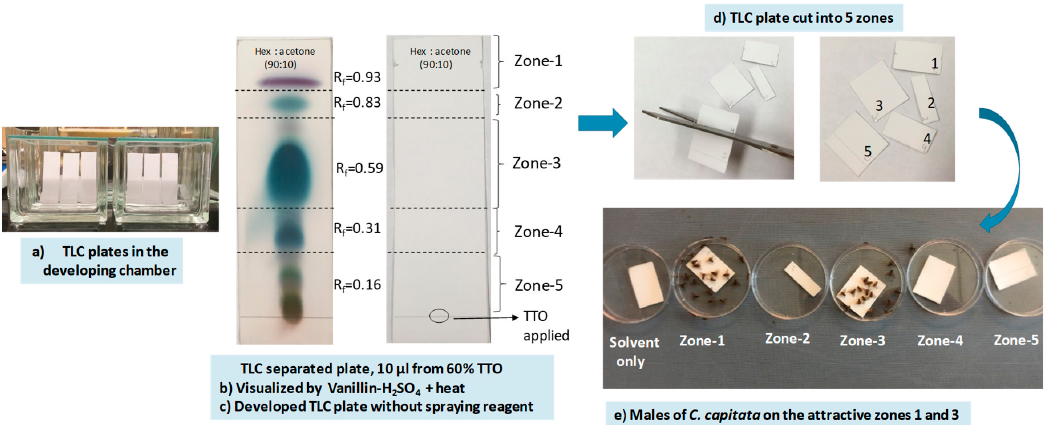
Figure 4. ( a ) Ten μ L of 60% TTO was spotted on the TLC plates and developed in the mixture of n